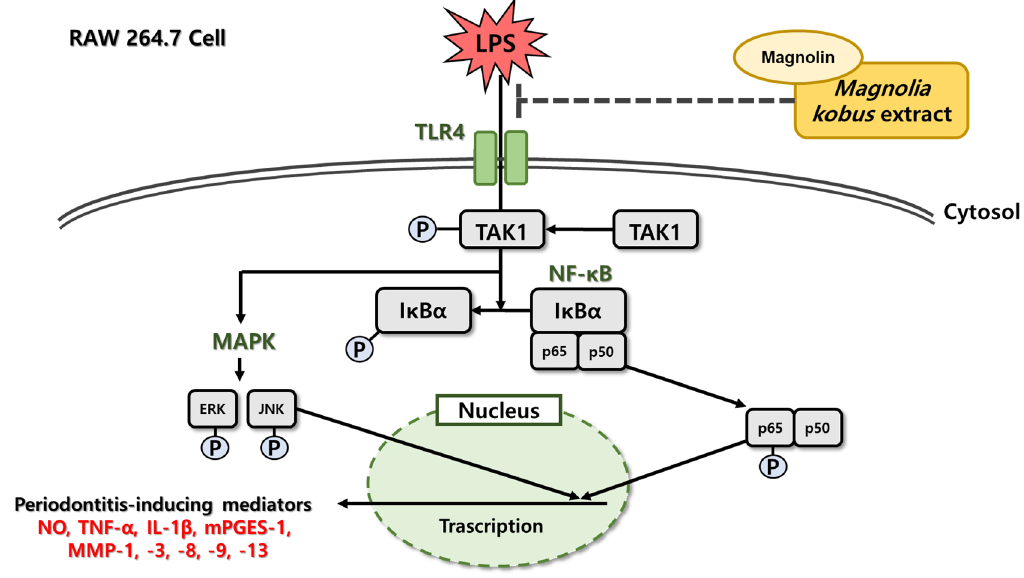
Figure 1. The anti-inflammatory pathway of MKE in RAW 264.7 cells.